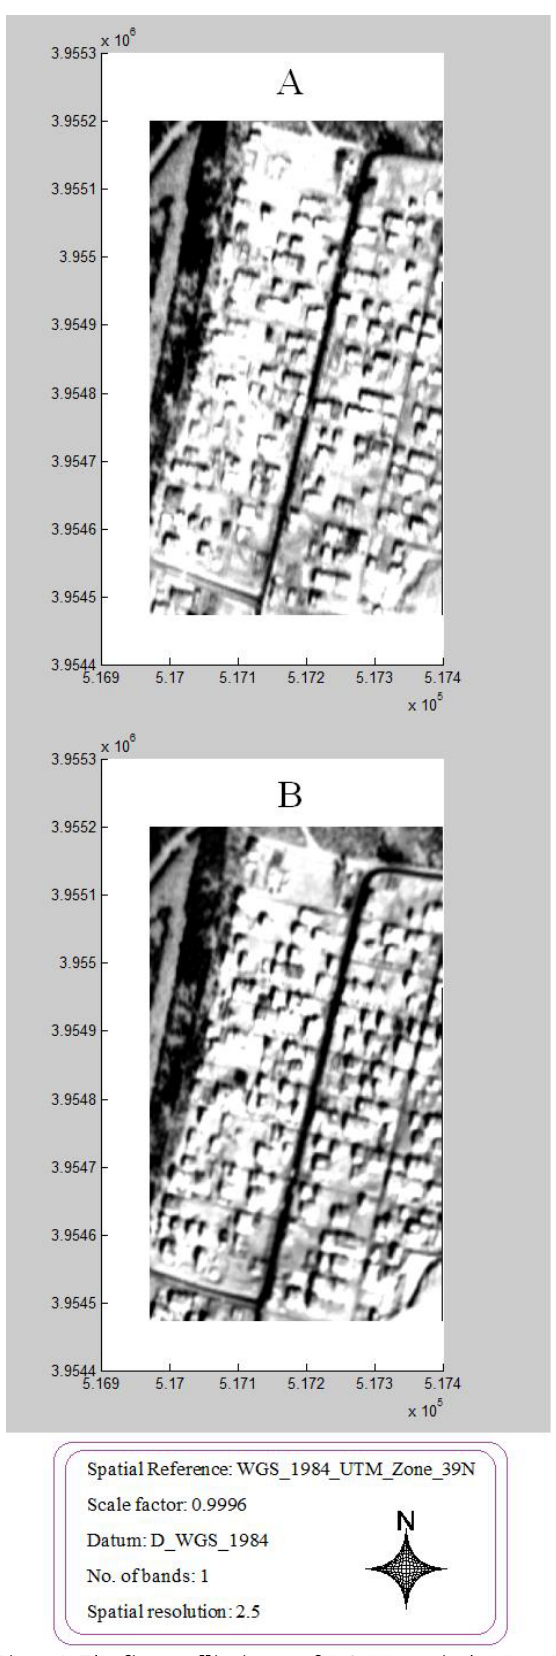
Figure 3. The first satellite image of IRS-P5 acquired at June 3, Figure 4. The first satellite image of QuickBird acquired at 2010 (A), and the second satellite image of IRS-P5 acquired at February 4, 2007 (A), and the second satellite image of October 3, 2010 (B) QuickBird acquired at March 11, 2011